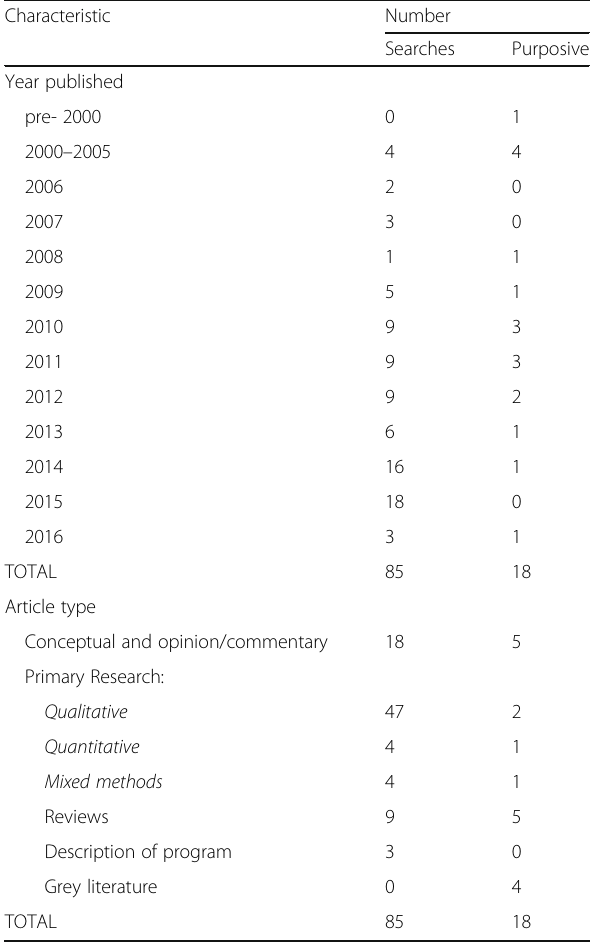
Table 2 Characteristics of articles